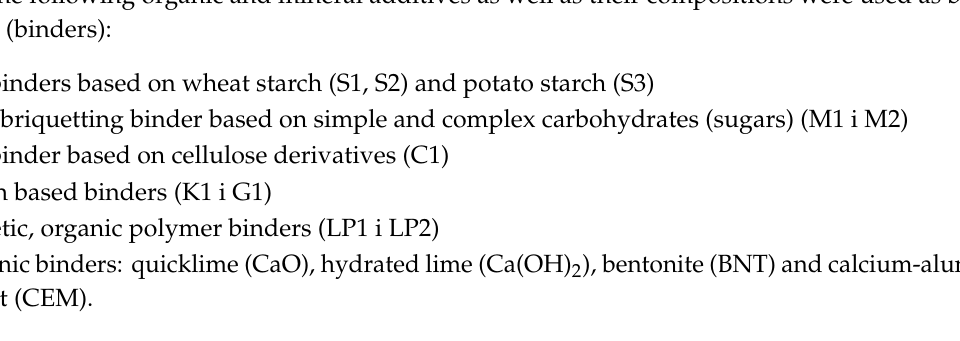
Figure 1. Cumulative particle size distribution of coal—Grain size 0–0.5 mm.